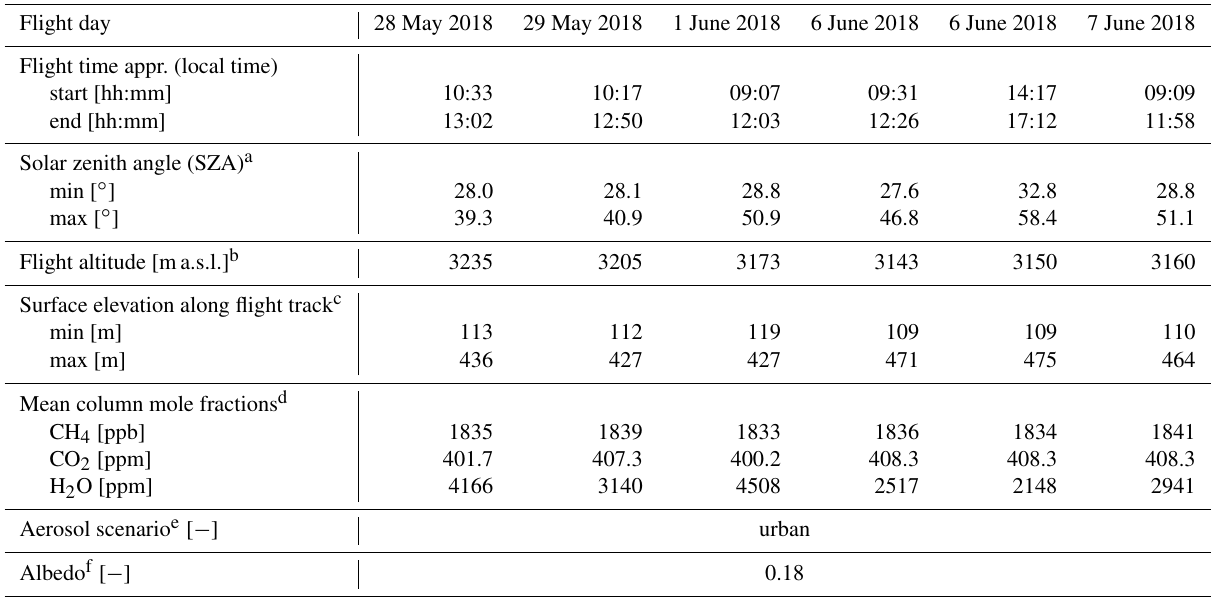
Table A1. General boundary conditions for the six flights performed during CoMet and also used for the radiative transfer model (RTM) simulations.